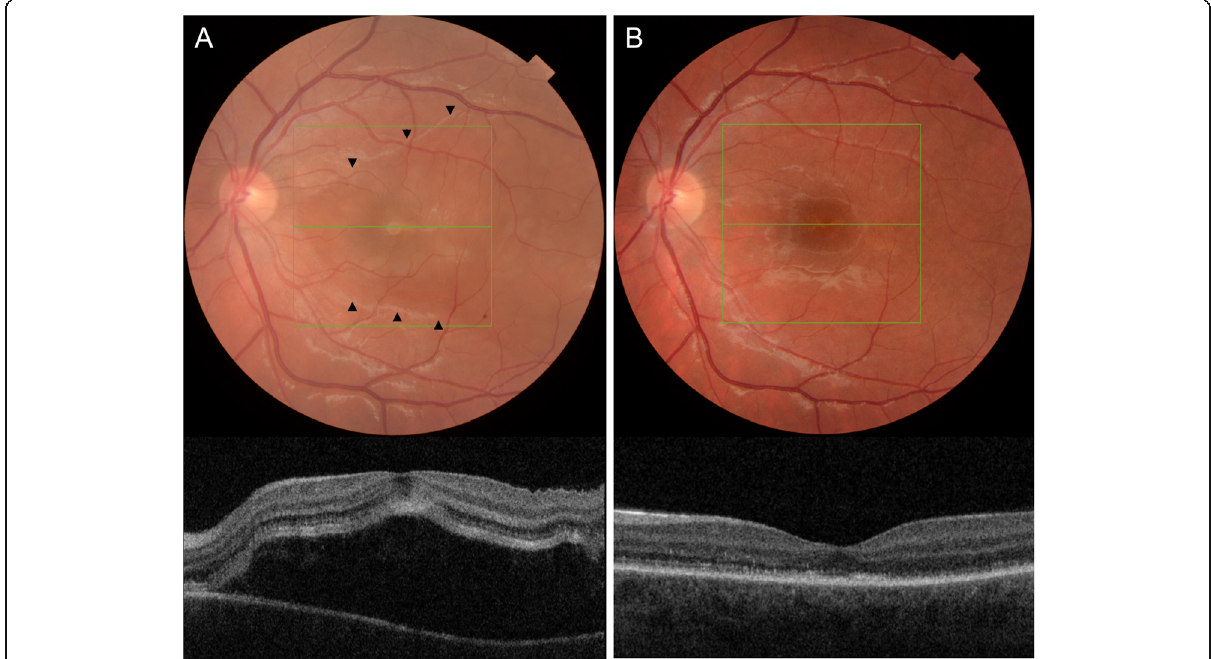
Fig. 3 Serous macular detachment secondary to posterior scleritis. ( A ) Colour fundus photograph and Topcon optical coherence tomography (OCT) at presentation. Delineation of the exudative detachment can be seen on the colour fundus photograph (black arrowheads). ( B ) Resolution of the serous macular detachment 3 weeks after initiation of oral